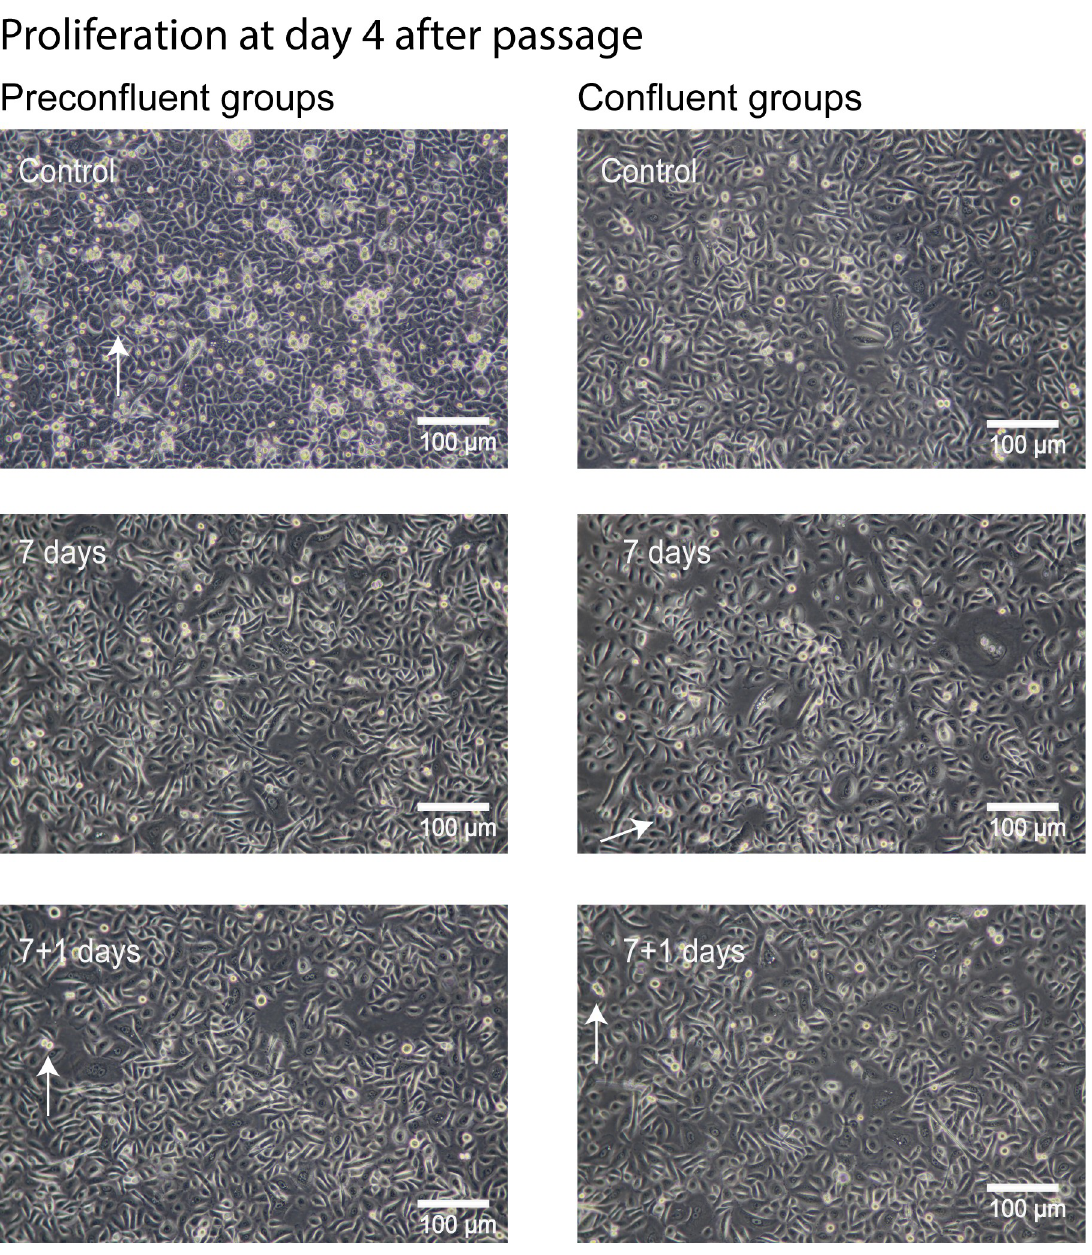
Fig 8. Experimental cells from Fig 5 were passaged. Cells are shown at day 4 after seeding (n = 3), 200X magnification. Cells from all groups could be passaged and grew to confluence. Passaged cells from the pre-confluent groups (left) divided more quickly. White arrows : dividing